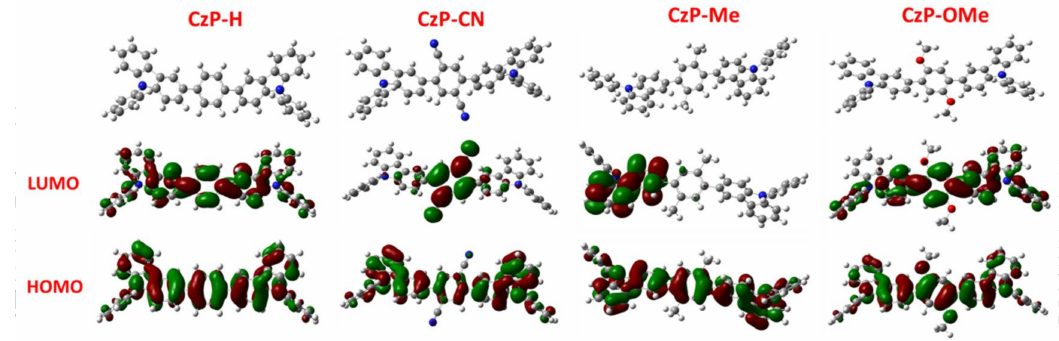
Figure 2. Highest occupied molecular orbitals (HOMOs) and lowest unoccupied molecular orbitals (LUMOs) for CzP-H, CzP-CN, CzP-Me, and CzP-OMe by density functional theory (DFT) calculations at the B3LYP/6-31G(d)